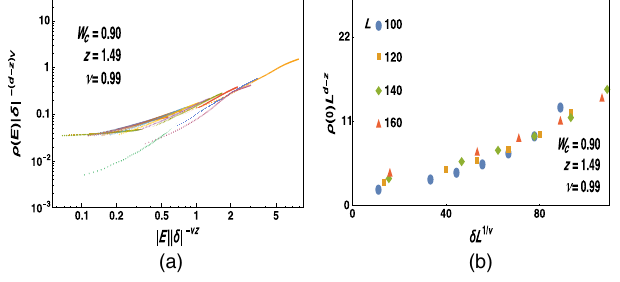
FIG. 24. Two types of data collapse in the presence of correlated potential disorder. (a) Finite energy collapse of ϱ ð E Þj δ j ð d − z Þ ν versus j E j δ − ν z in a system with L ¼ 160 . All data fall on two branches: top one corresponds to the metallic phase, while the bottom one corresponds to the semimetallic phase. (b) Finite-size data collapse of ϱ ð 0 Þ L d − z versus δ L 1 = ν . For these 0 . 9 , z ¼ 1 . 49 , and ν ¼ 0 . 99 two data collapses we take W c ¼